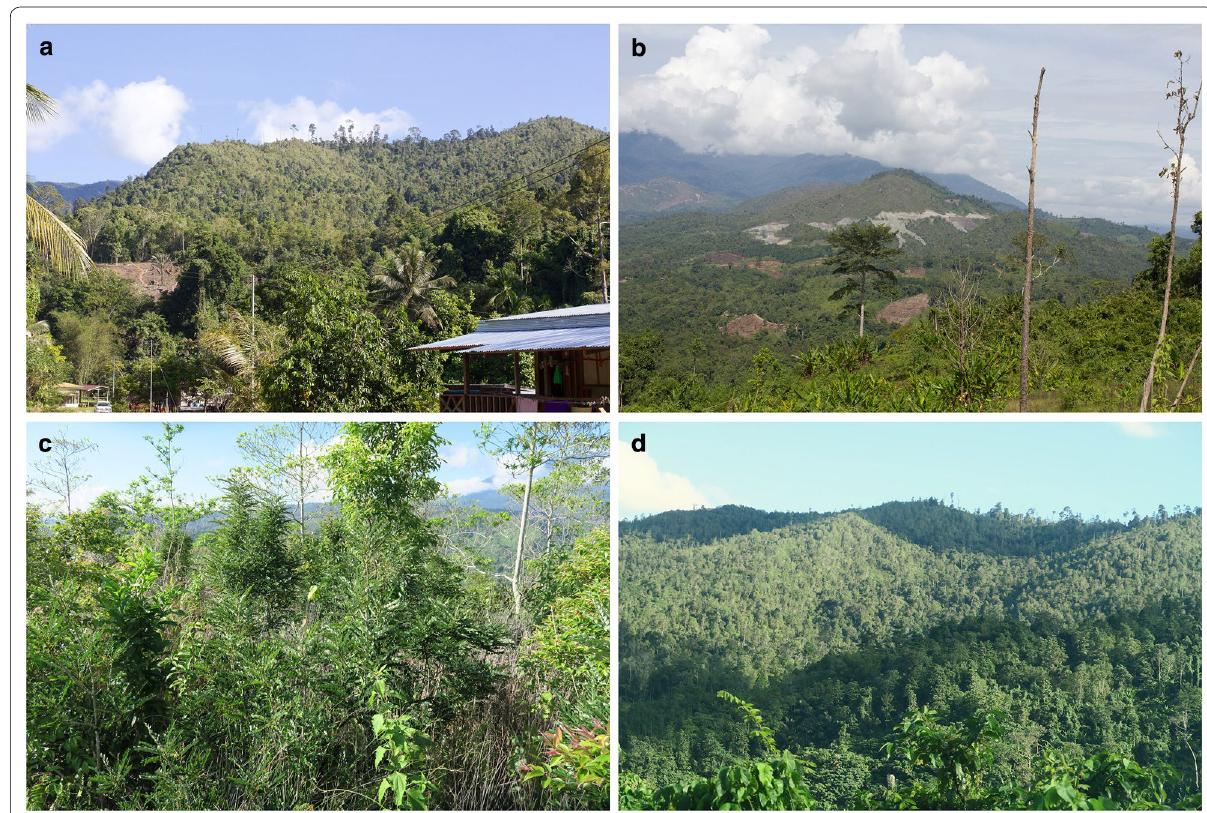
Fig. 1 Different aspects of the habitat of P. rufuschaneyi in Sabah, Malaysia. a Lompoyou Hill seen from Nalumad village; b Garas—the eastern end of Lompoyou Hill, the outcropping ultramafic (serpentinite) bedrock is clearly visible in the road cuts; c Phyllanthus rufuschaneyi growing in situ on Lompoyou Hill; d the summit of Lompoyou Hill with secondary scrub and dead standing trees after forest fires. Images by A. van der